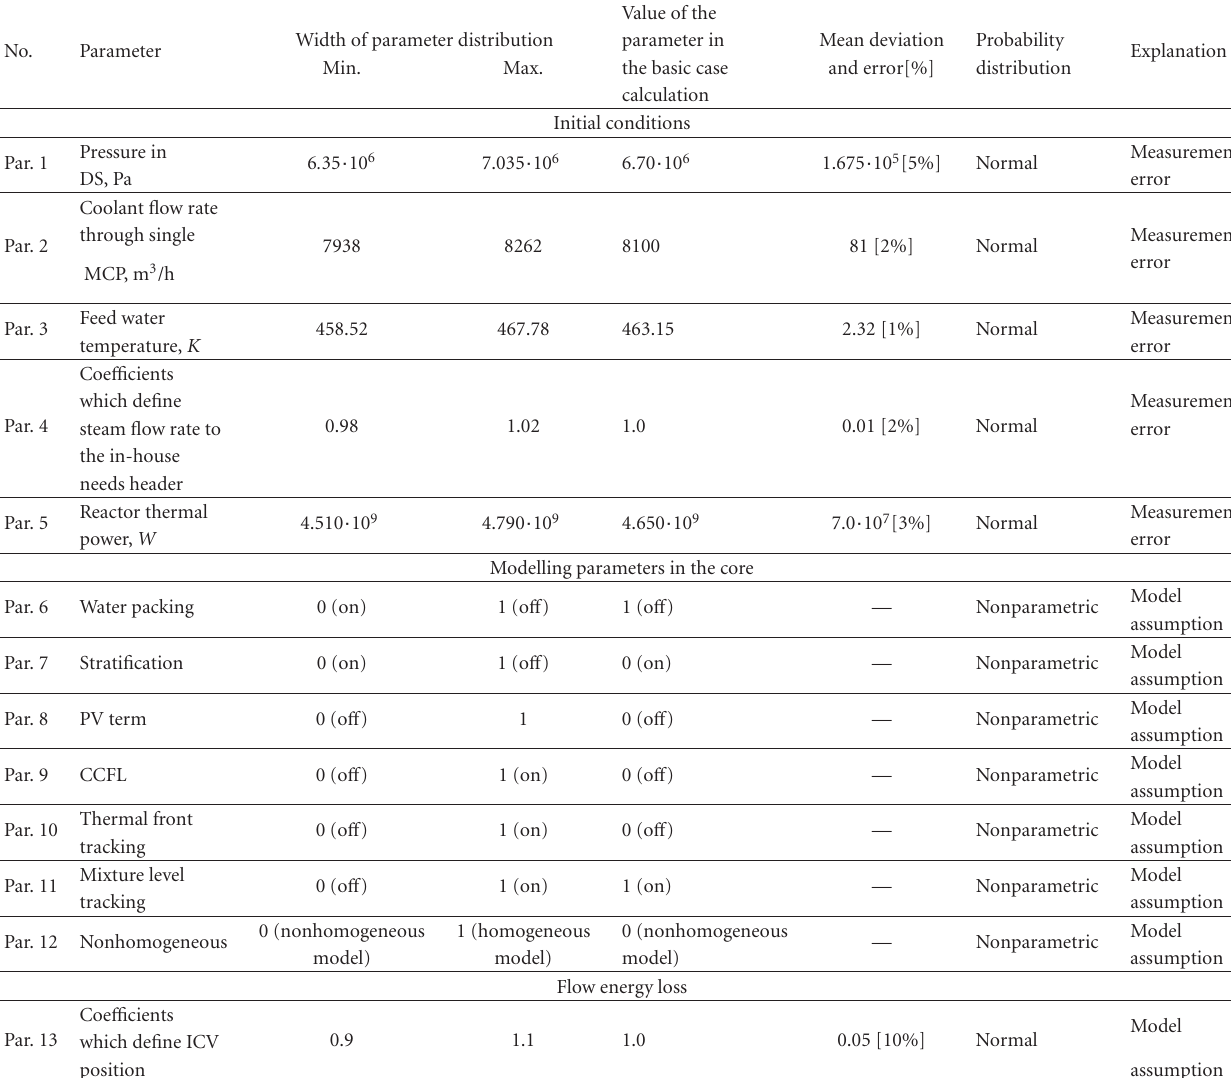
Table 1: Parameters which may impact the uncertainty of calculation results in case of all MCPs